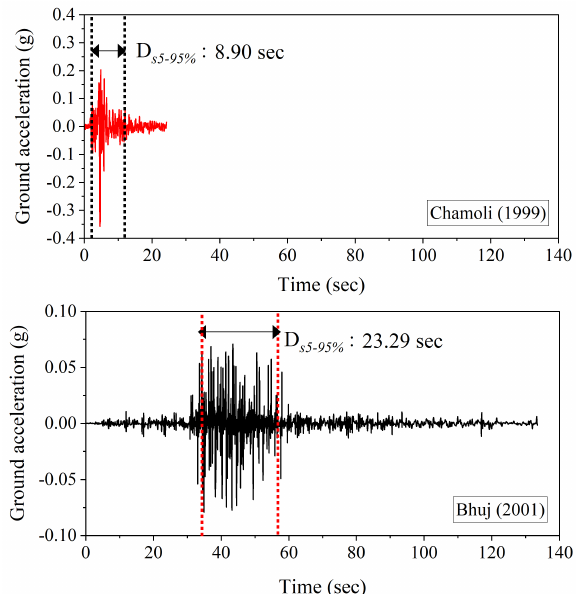
Fig. 2. Ground Acceleration time histories of Bhuj (2001) and Chamoli (1999) records.